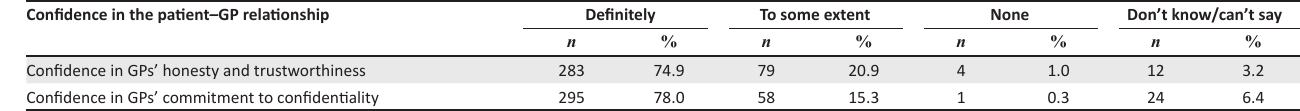
TABLE 3b: Patients’ perspective on the consultation, relationship with the general practitioner and care enablement ( N = 378). Confidence in the patient–GP relationship